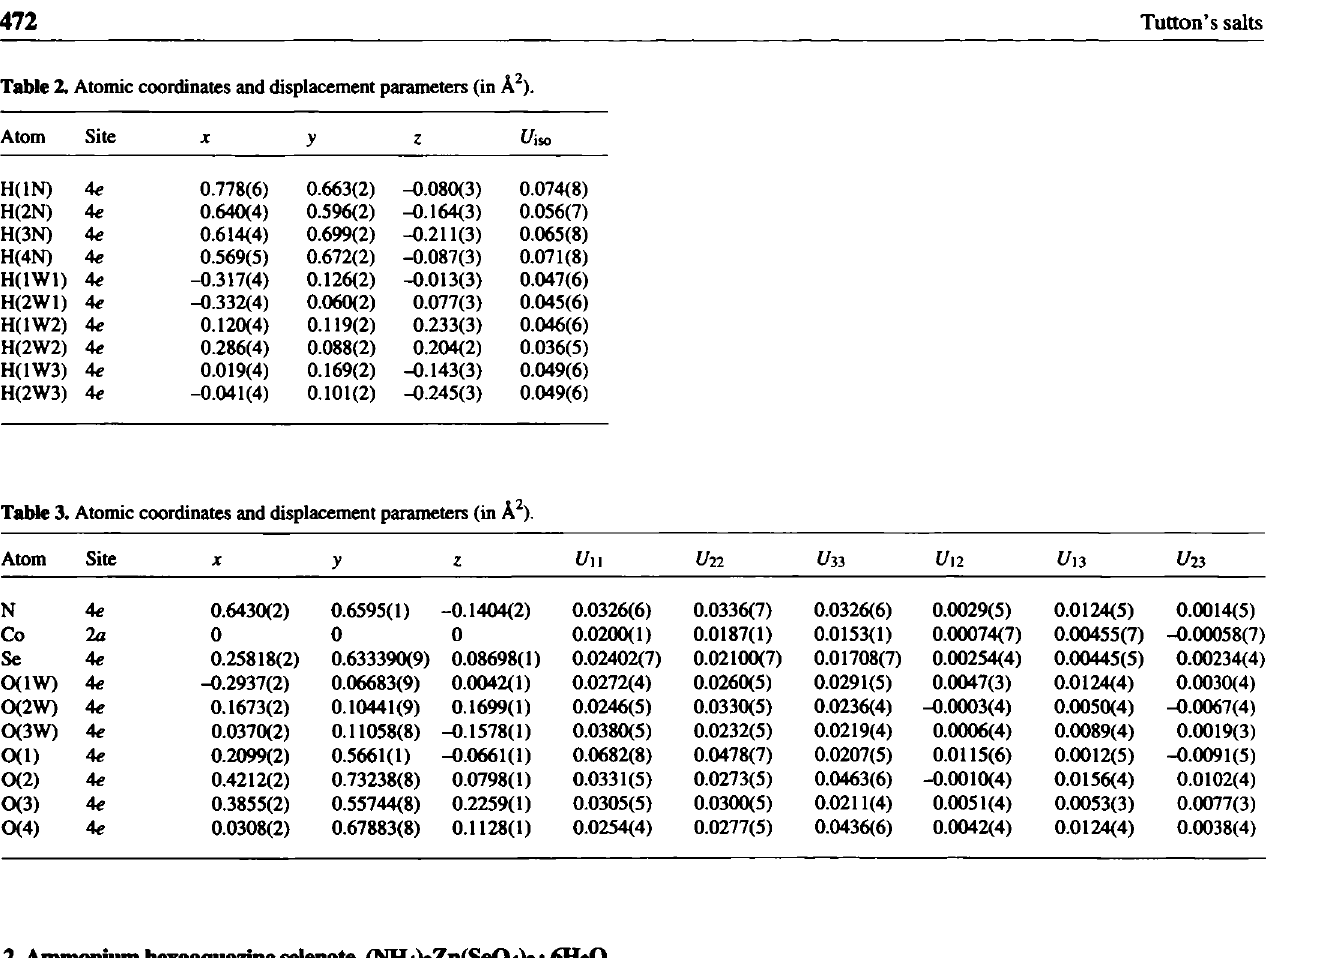
Table 4. Data collection and handling. Table 5. Atomic coordinates and displacement parameters (in Â 2 ).